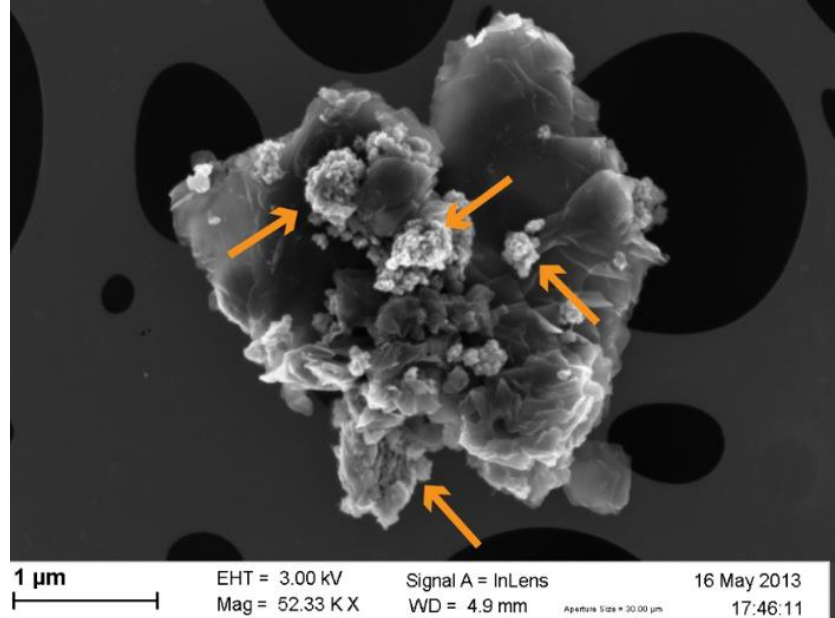
Figure 7. SEM image of large micrometric agglomerates of functionalized silica-coated Fe 3 O 4 MNPs